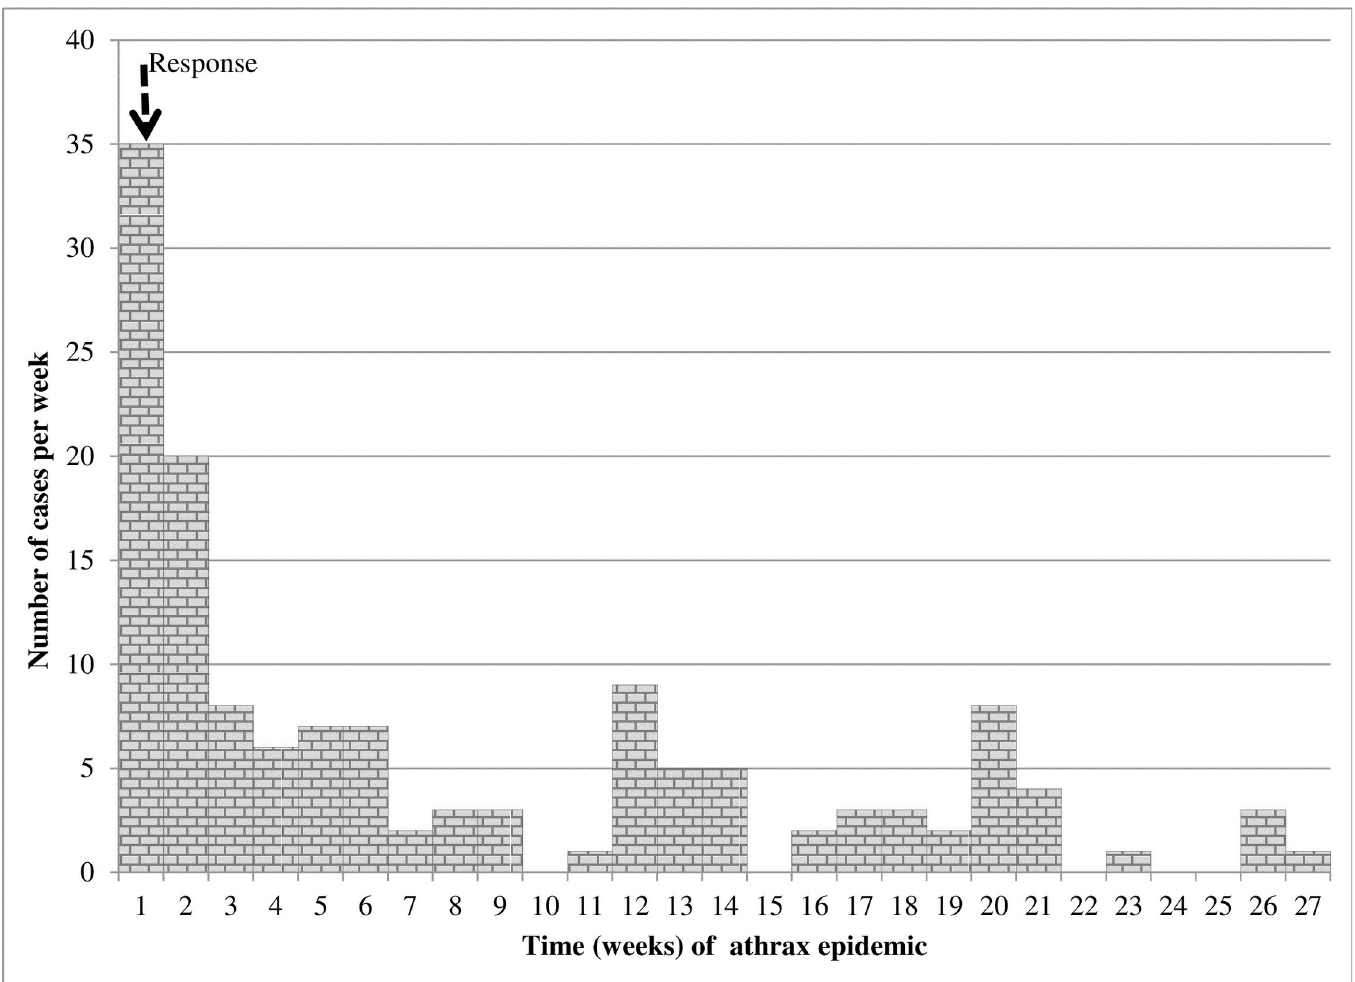
Fig 6. Epidemic curve showing patterns of epidemic spread for weekly anthrax cases in Hippopotamus in2010. O utbreak occurred in less distinct waves, lasted 27 weeks from 11 June to December and died after 3 generations. Dashed line shows time at onset of the outbreak in week 1 when management intervention for carcass disposal was initiated. Number of new cases drastically declined immediately following